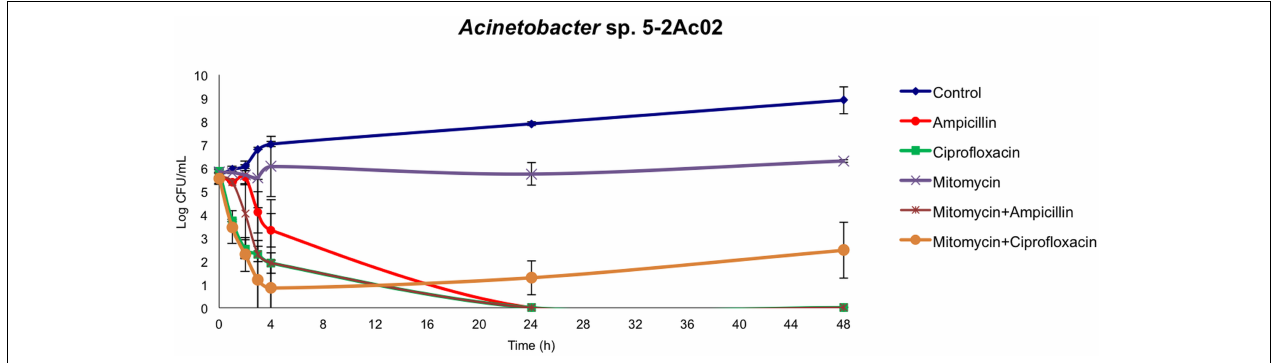
FIGURE 1 | Killing curves of Acinetobacter sp. 5-2Ac02 in the presence of antimicrobials and/or mitomycin C.